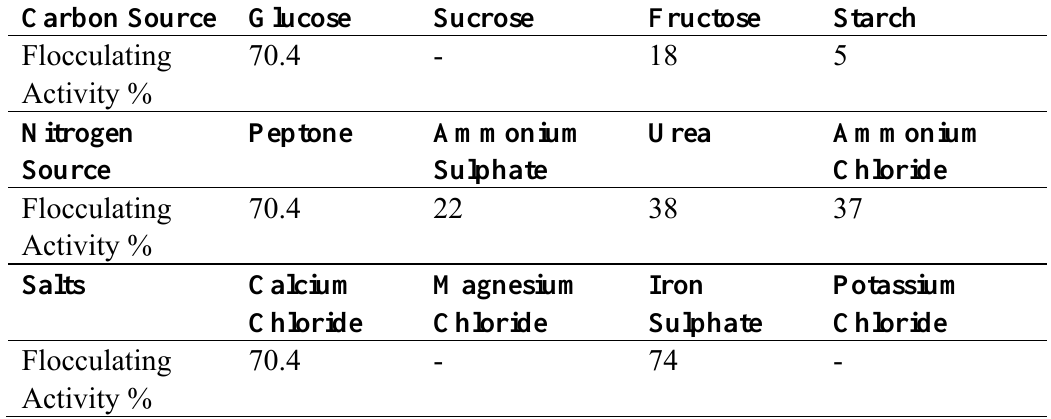
Table 1. Effects of composition of medium on the bioflocculant production by Virgibaccilus sp.